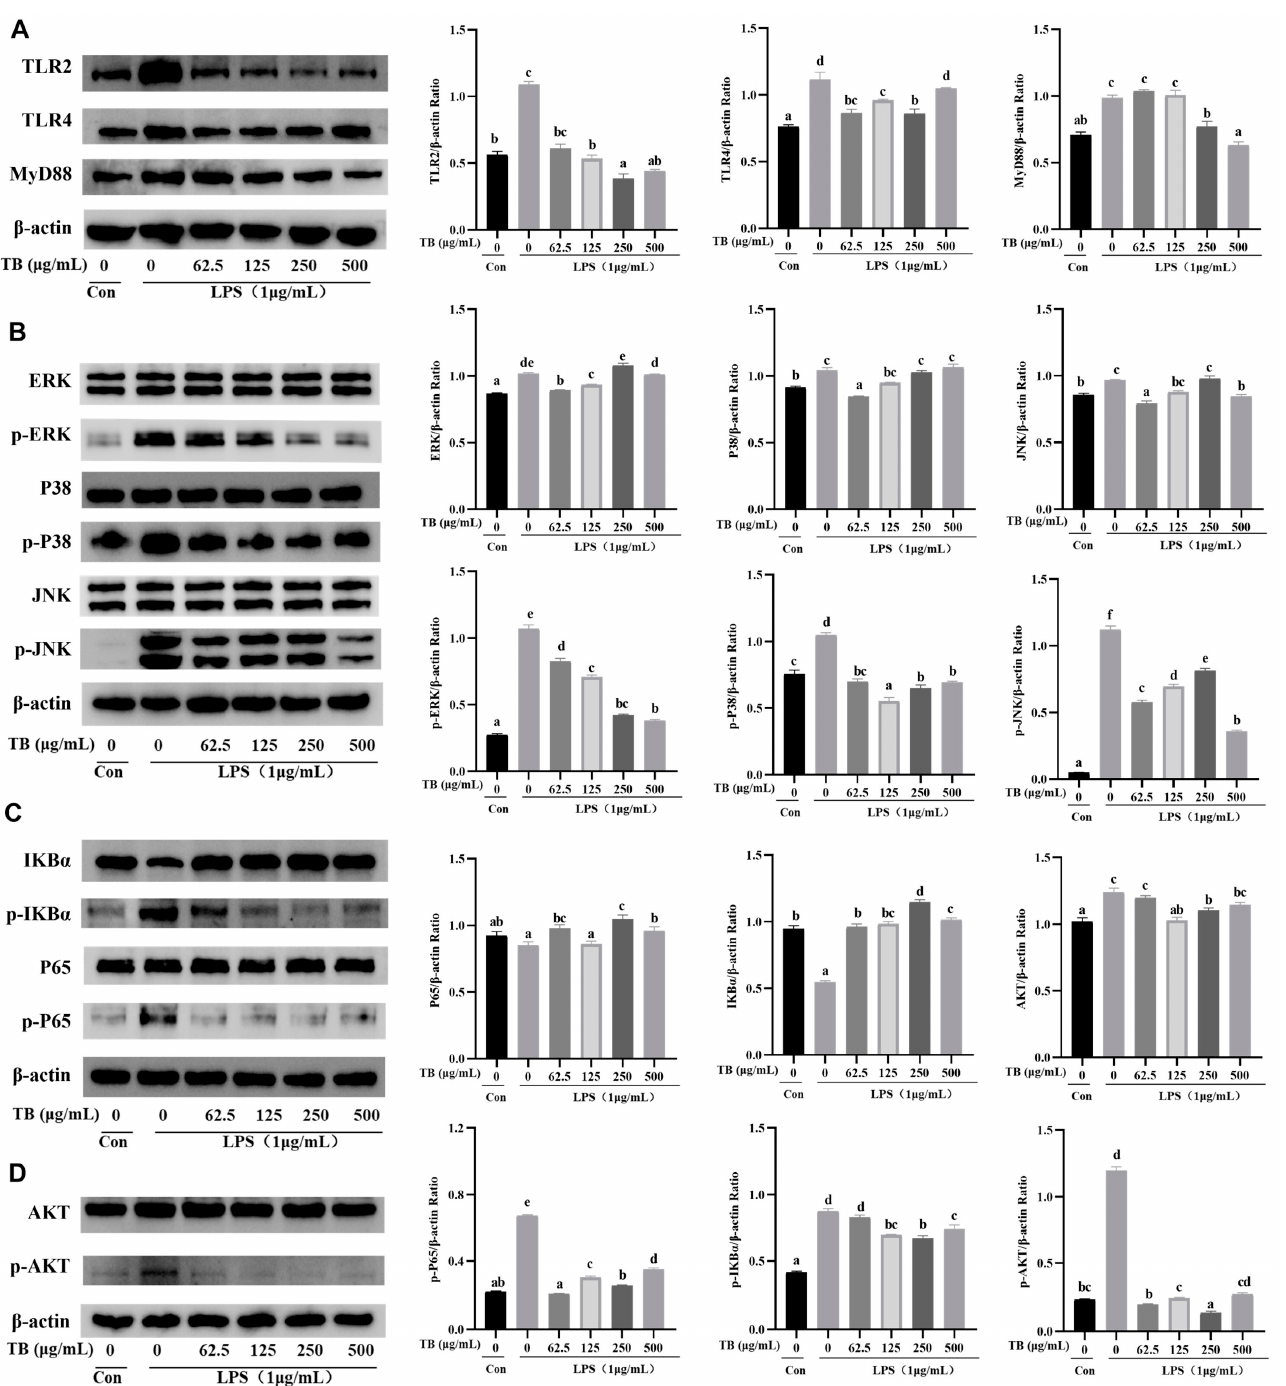
Figure 4. Western blot of anti-inflammatory effects of TB on TLR2/4-mediated pathway in RAW264.7 cells. ( A ) The expressions of TLR2/4 and MyD88. ( B ) The expressions of key proteins of the NF- κ B signaling pathway. ( C ) The expressions of key proteins of the MAPK signaling pathway. ( D ) The expressions of key proteins of the PI3K–AKT signaling pathway. β -actin was used as a loading control. The statistically significant differences are marked with different letters (a, b, c, d, e, f).